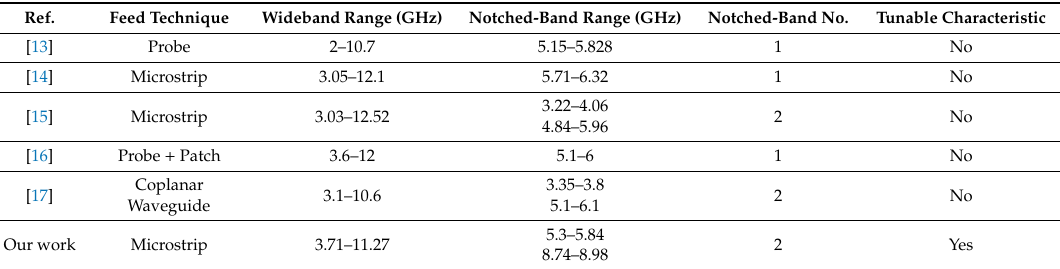
Figure 11. Normalized radiation pattern of the proposed DRA at 4 GHz: ( a ) 0V; ( b ) 1.5V; ( c ) 5.0V; and ( d ) 30.0V. Table 3. Performance comparison with other band-notched DRAs.